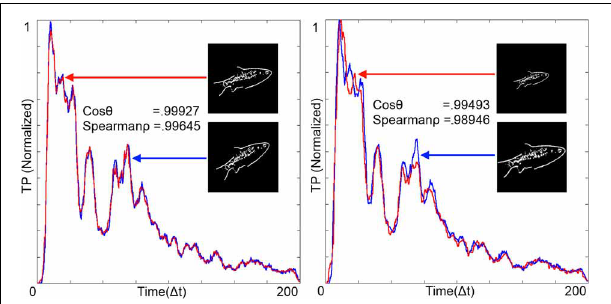
FIGURE 9 | Temporal patterns (TPs) from the RPN illustrating rotational invariance (left) and scale invariance (right). Images were projected on to the disc at t = 0 and all time scales were normalized to 200 by resampling the TPs and aligning them together. Measures of similarity between the TPs are given in the form of the Cosine Similarity (cos θ ) and Spearman’s Rank Correlation Coefficient (Spear’ ρ ). Both of these measures show high degrees of similarity between the images. Images where projected onto a disc with (cid:2) = 200 arms and N = 200 neurons per arm.